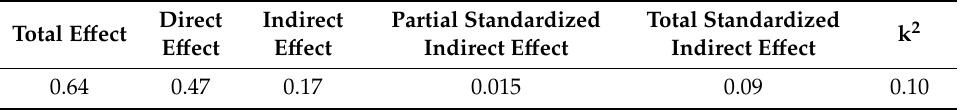
Table 4. Model 1 e ff ect indices. In the table, the coe ffi cients for all the e ff ects of the mediation model number 1 are presented.